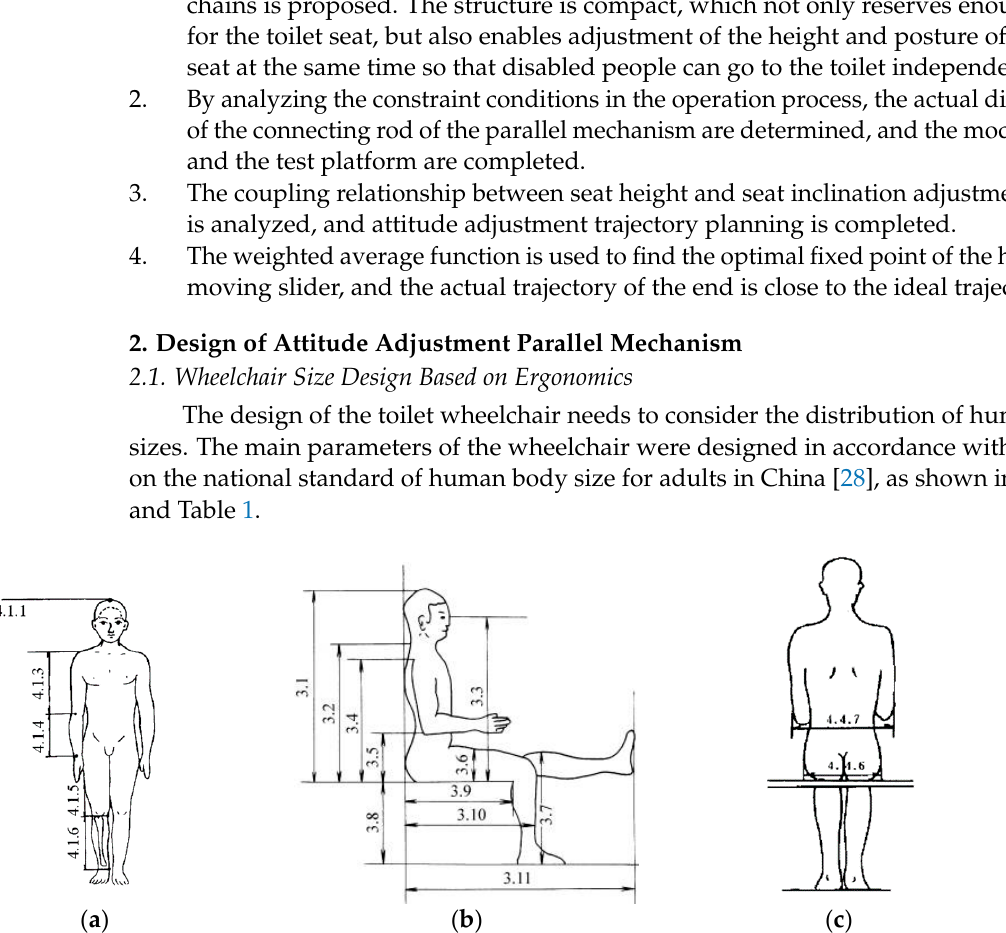
Figure 1. Chinese adult human body size: ( a ) standing size; ( b ) side-view size in sitting position; ( c ) back-view size in sitting position. Table 1. Chinese adult body size.